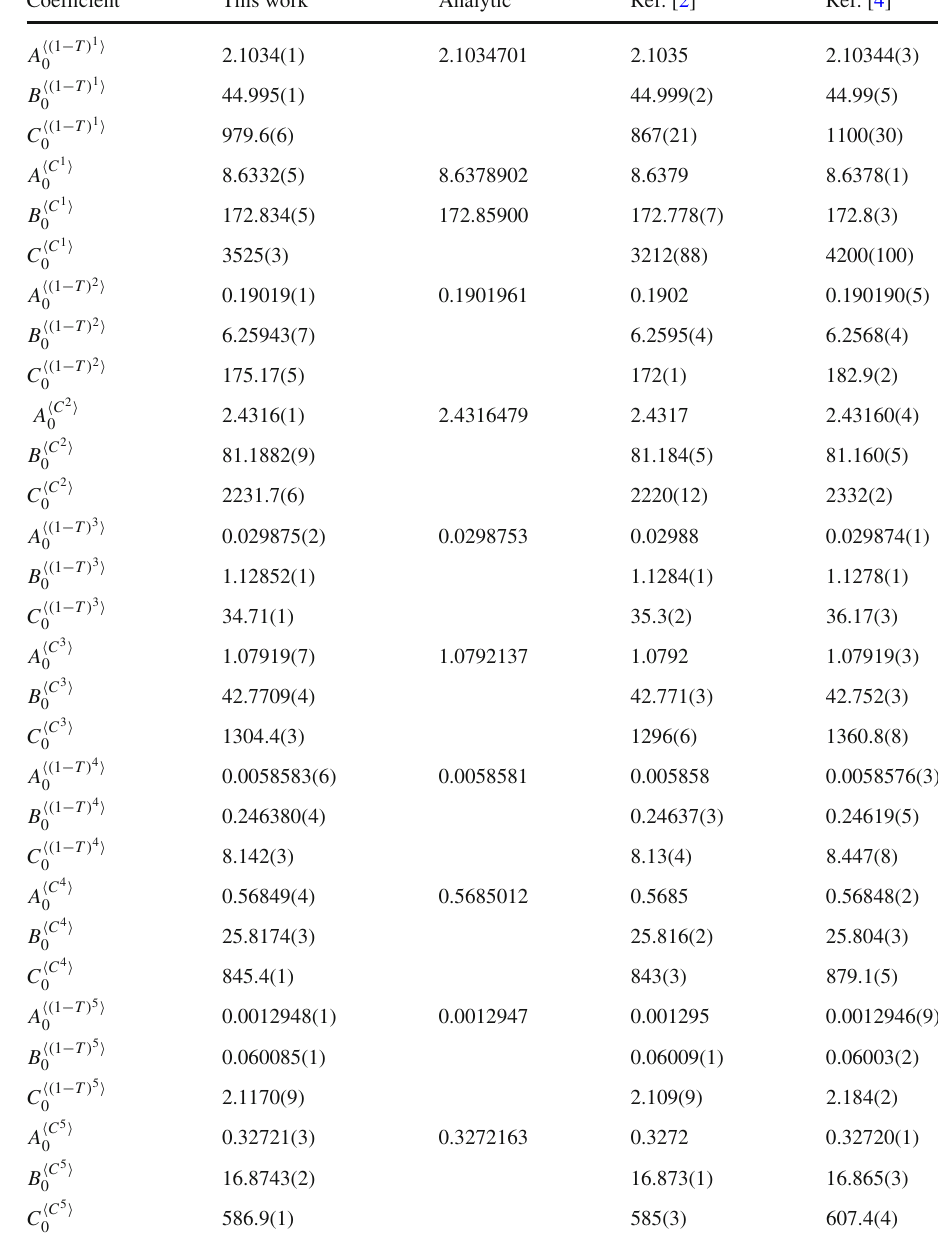
Table 1 LO, NLO and NNLO contributions to the moments of event shapes. For the details on the analytic calculation